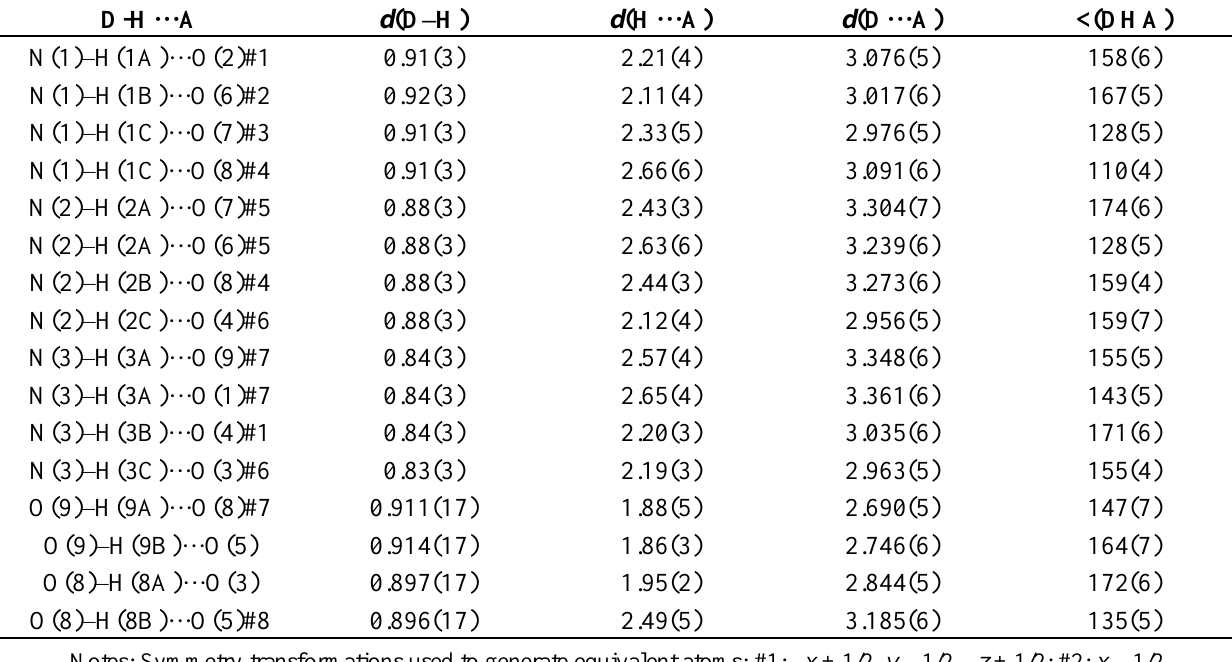
Table 3. Hydrogen bond lengths (Å) and angles (°) for fac -[Co(NH 3 ) 3 (C 2 O 4 )(H 2 O)]NO 3 ·H 2 O ( 2 ).